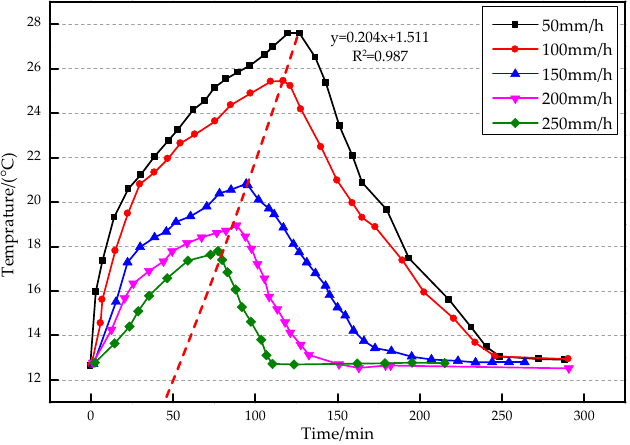
Figure 16. Sensors 2019 , 19 , x FOR PEER REVIEW